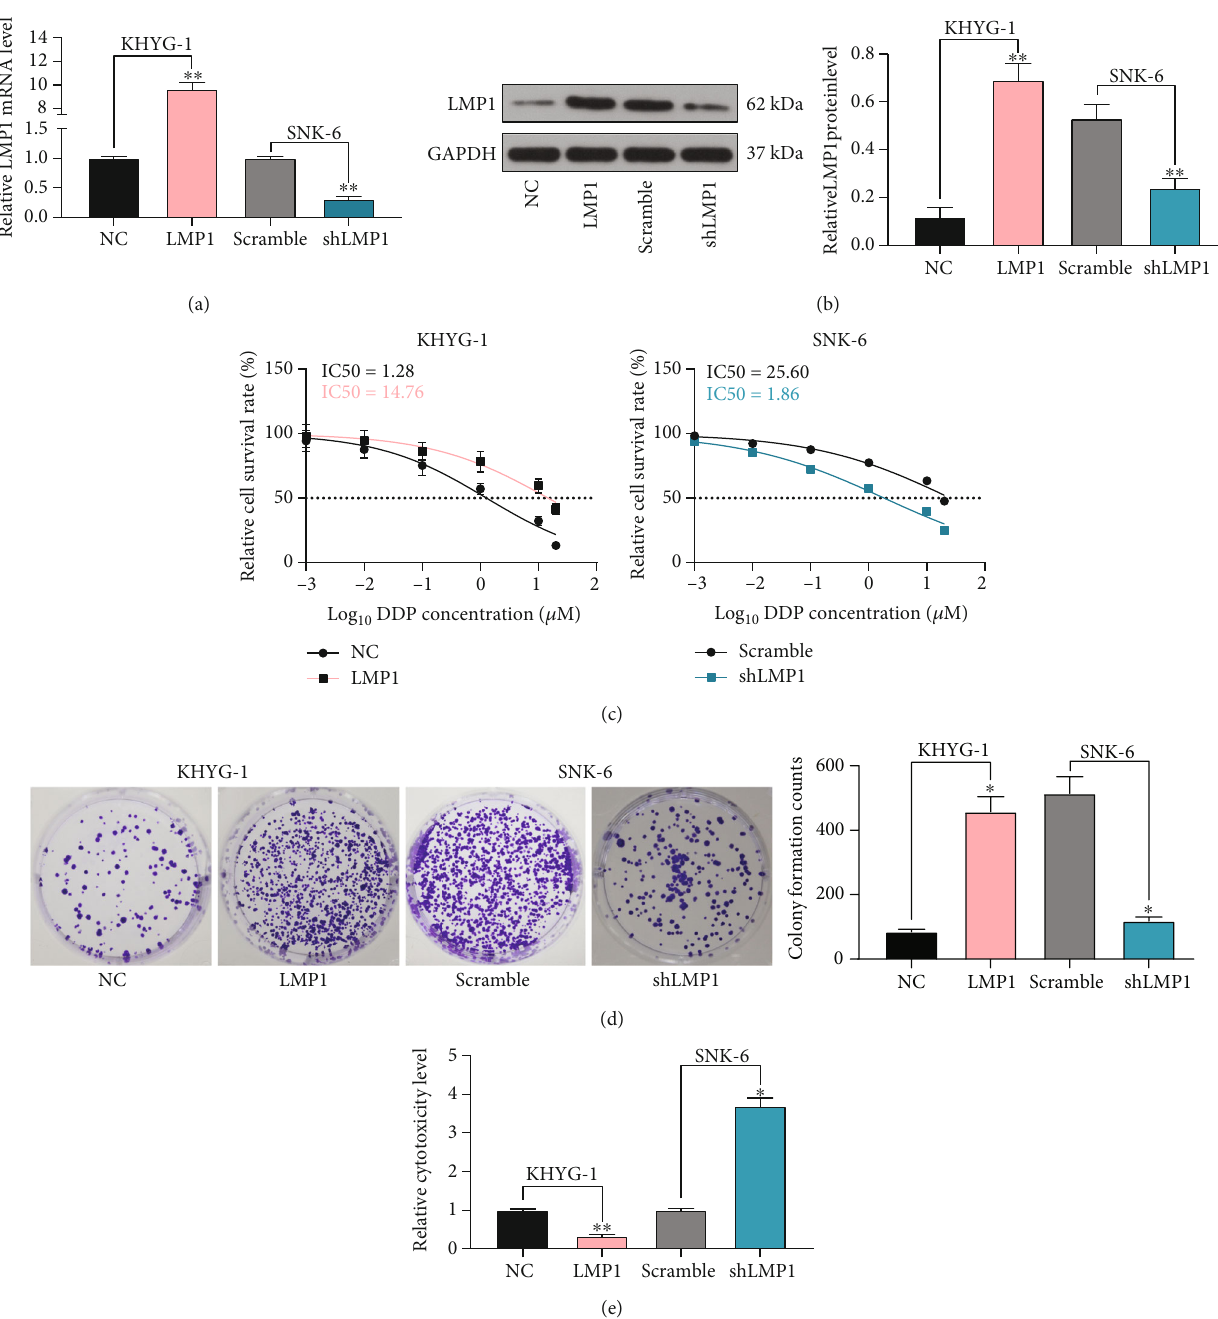
Figure 1: LMP1 strengthens DDP resistance in the SNK-6 and KHYG-1 cells. EBV-LMP1 shRNA was transfected into the SNK-6 cells, and lentivirus overexpression vector containing EBV-LMP1 was used to infect the KHYG-1 cells. (a) The SNK-6 cells poorly expressing LMP1 and the KHYG-1 cells highly expressing LMP1 were successfully constructed as detected by RT-qPCR. (b) LMP1 expression in the KHYG-1 and SNK-6 cells as detected by western blot analysis. (c) IC50 value of KHYG-1 and SNK-6 cells to DDP detected by CCK-8 assay. (d) Cell proliferation ability detected by colony formation assay. (e) The toxicity of DDP to each group of cells detected by LDH cytotoxicity test. All data are displayed in the form of mean ± standard deviation . (a, b, d, and e) One-way ANOVA and Tukey ’ s multiple comparison test are used to test the signi fi cant di ff erence of data. (c) Two-way ANOVA and Tukey ’ s multiple comparison test are used to test the signi fi cant di ff erence of data. ∗ p < 0 : 05 , ∗∗ p < 0 : 01